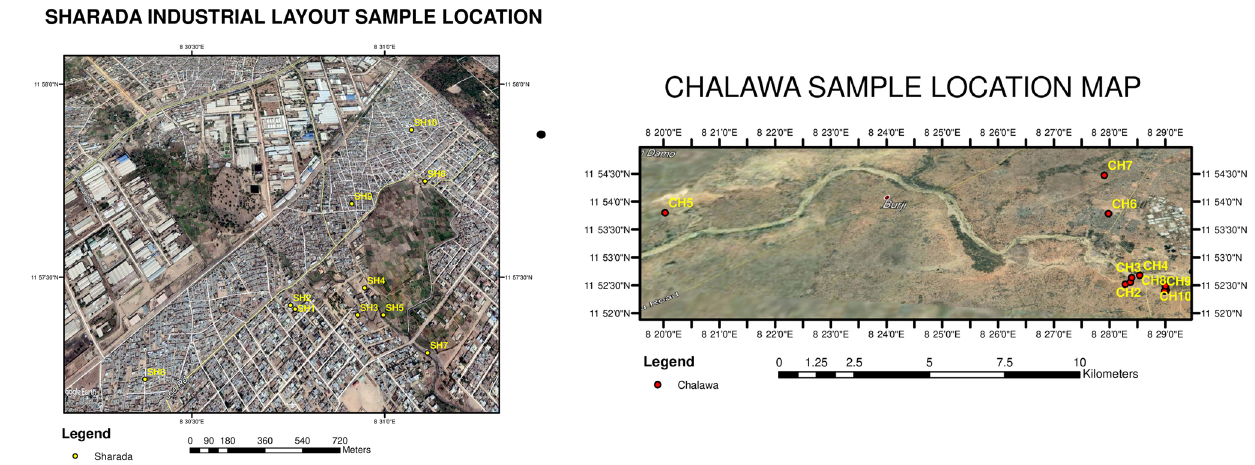
Fig. 1 Location maps of two industrial areas with groundwater sampling points